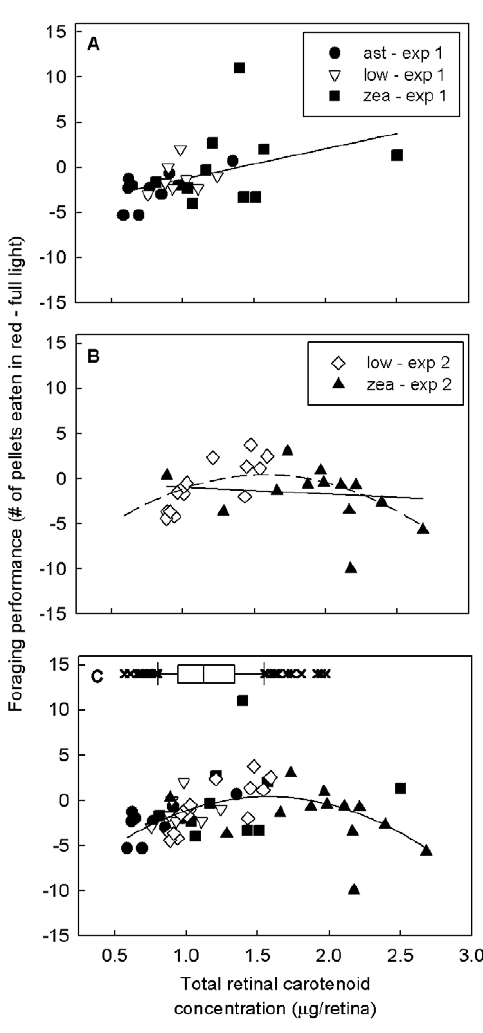
Figure 6. Retinal carotenoid levels and low contrast foraging performance. Relative number of food pellets eaten in the low- contrast red-light, as compared to high-contrast full-light, in the post- supplementation period for (A) experiment one, (B) experiment two, and (C) experiments one and two combined. The diet treatments within experiments one and two are denoted with different symbols. The box plot in at the top of figure C represents the natural range of variation in retinal carotenoid levels among wild house finches reported by Toomey and McGraw [18].